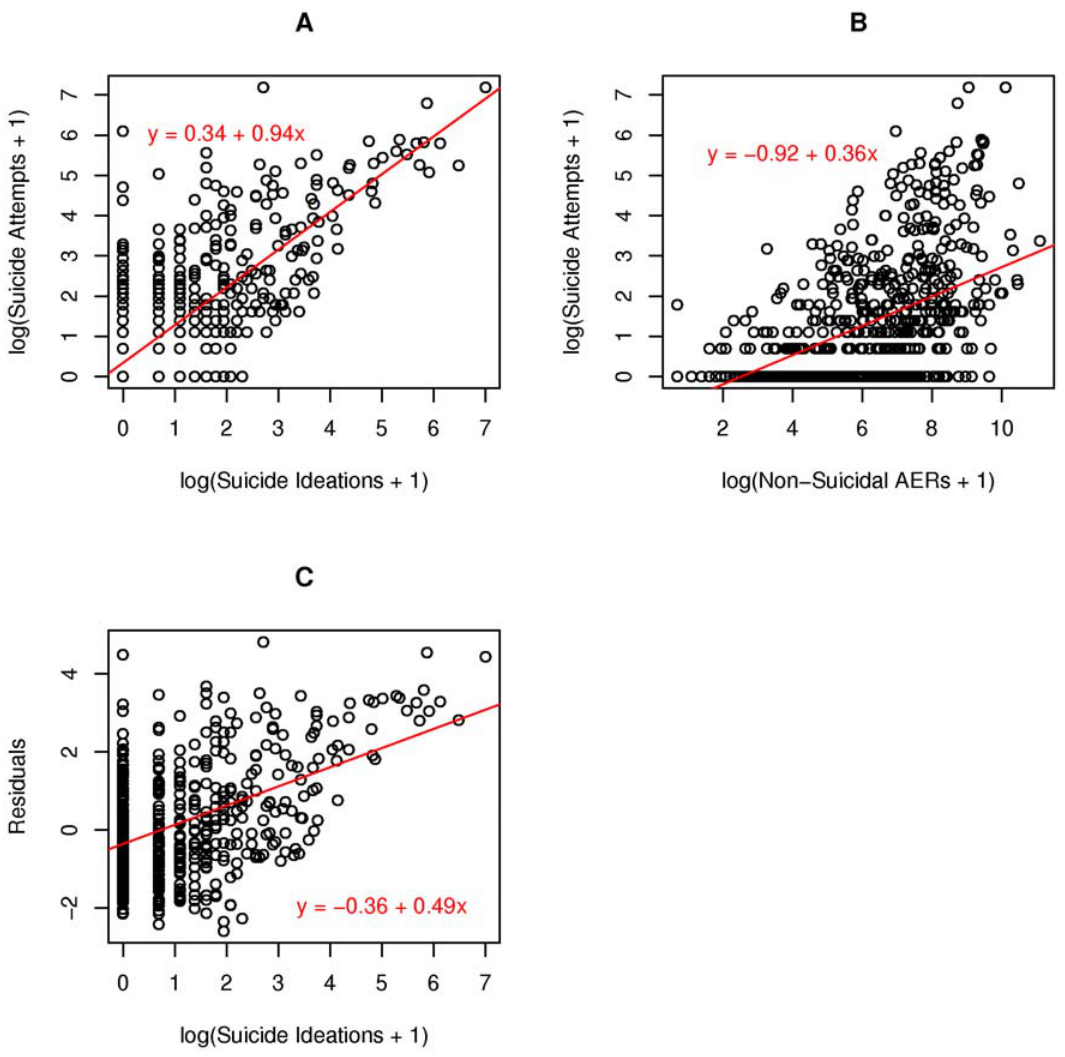
Figure 1. Log-log scatter plots.